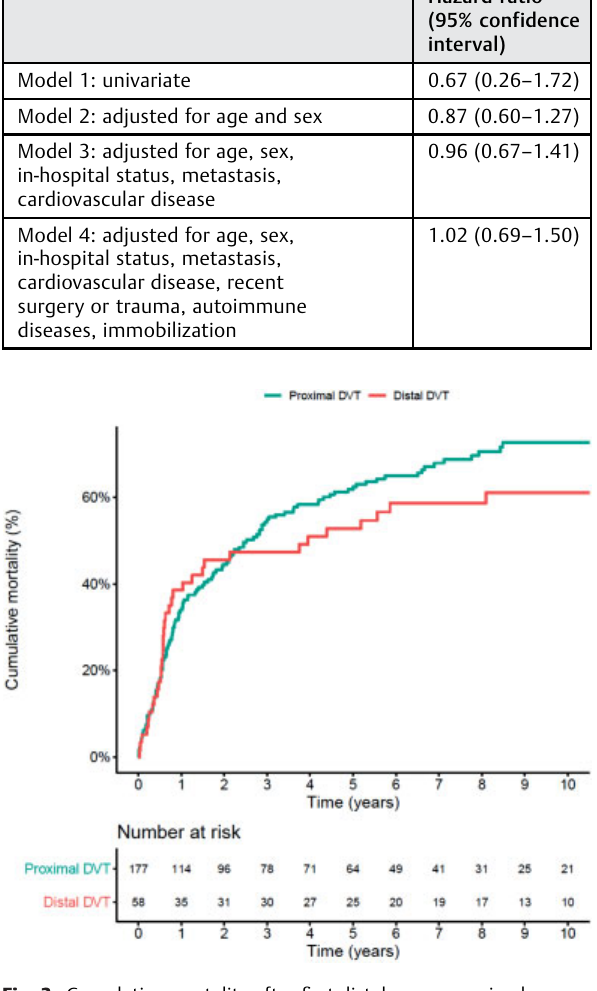
Fig. 3 Cumulative mortality after fi rst distal versus proximal cancer- associated deep vein thrombosis